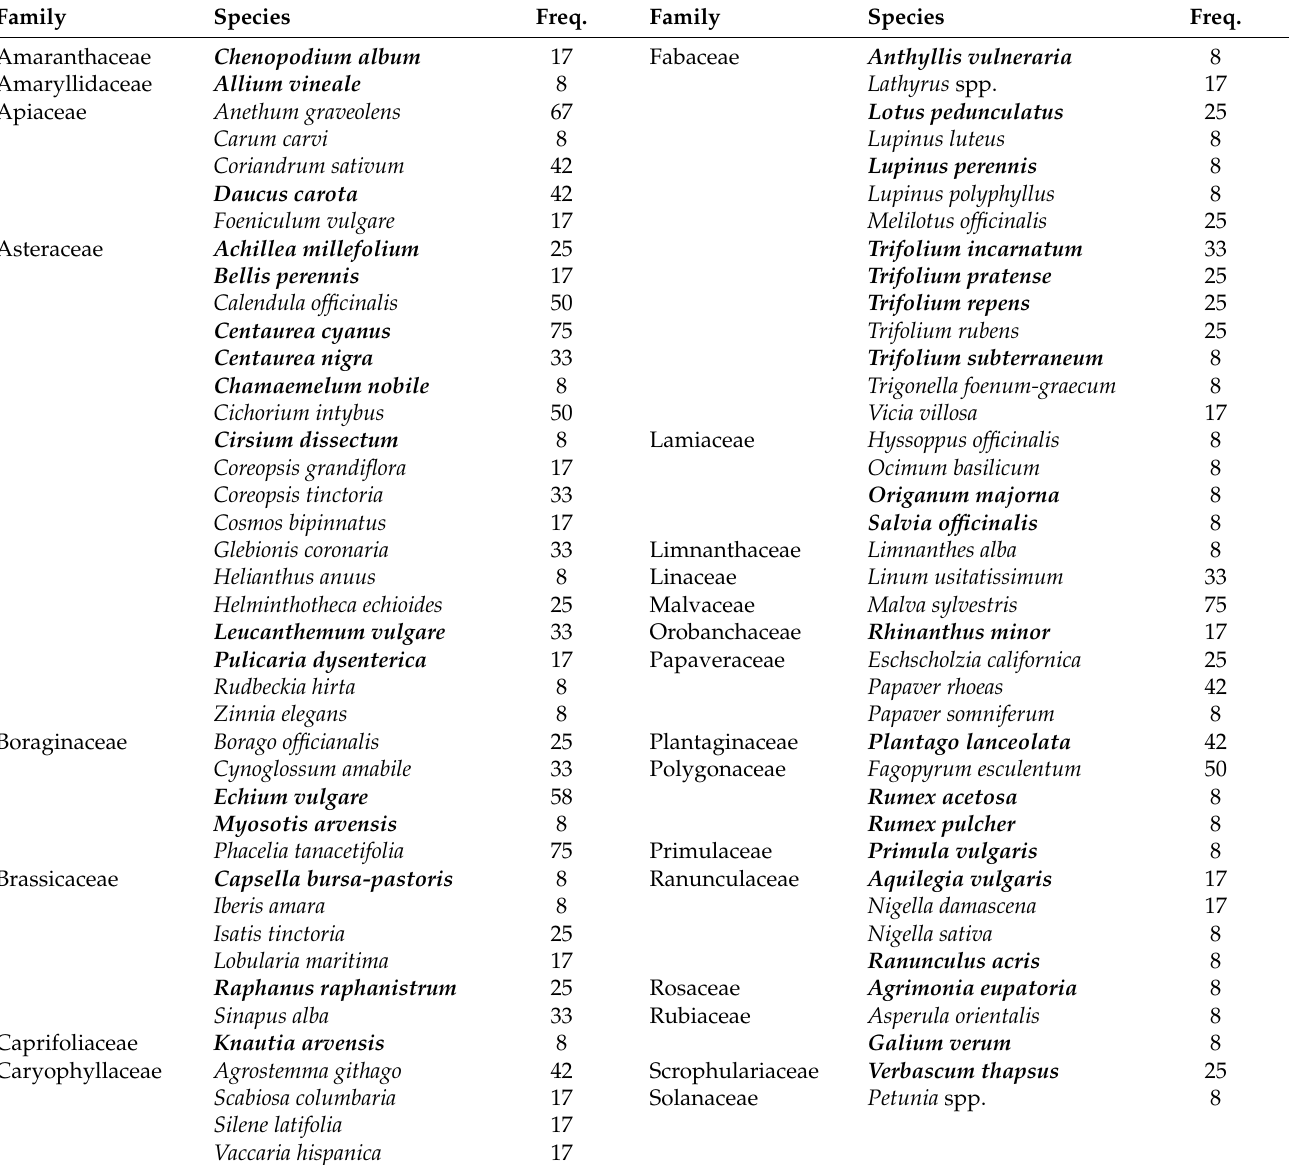
Table 4. Plant families and species found within twelve brands of wildflower seeds purchased in Ireland in 2022. Species names in bold indicate species is native to Ireland. Frequency is the proportion (%) of seed brands (from 12) in which each species was